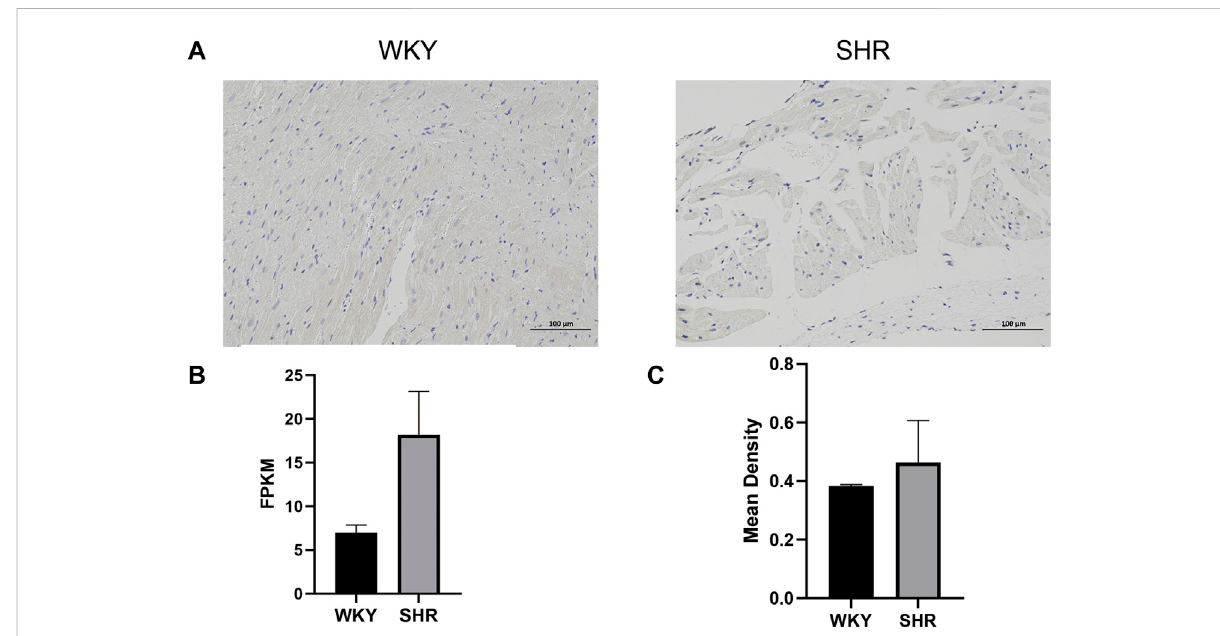
FIGURE 7 (A) Immunohistochemical analysis of the left atrium in different groups: the TGF-beta-positive cells manifested as buffy, and the nucleus was stained blue. (B) Expression levels of TGF beta in SHR and WKY: the X -axis represents different groups, and the Y -axis represents FPKM. (C) Mean density of Immuno fl uorescence staining: the X -axis represents different groups, and the Y -axis represents the mean density. WKY, Wistar-Kyoto; SHR, spontaneously hypertensive rat; FPKM, fragments per kilobase of exon per million reads